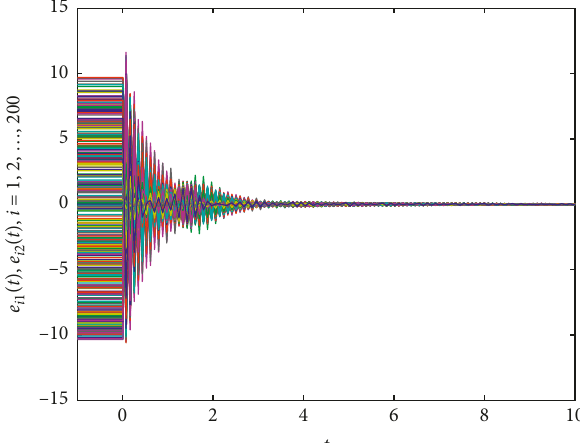
Figure 15: Time evolution of nodes’ states x under continuous feedback, i � 1 , 2 , ... ,